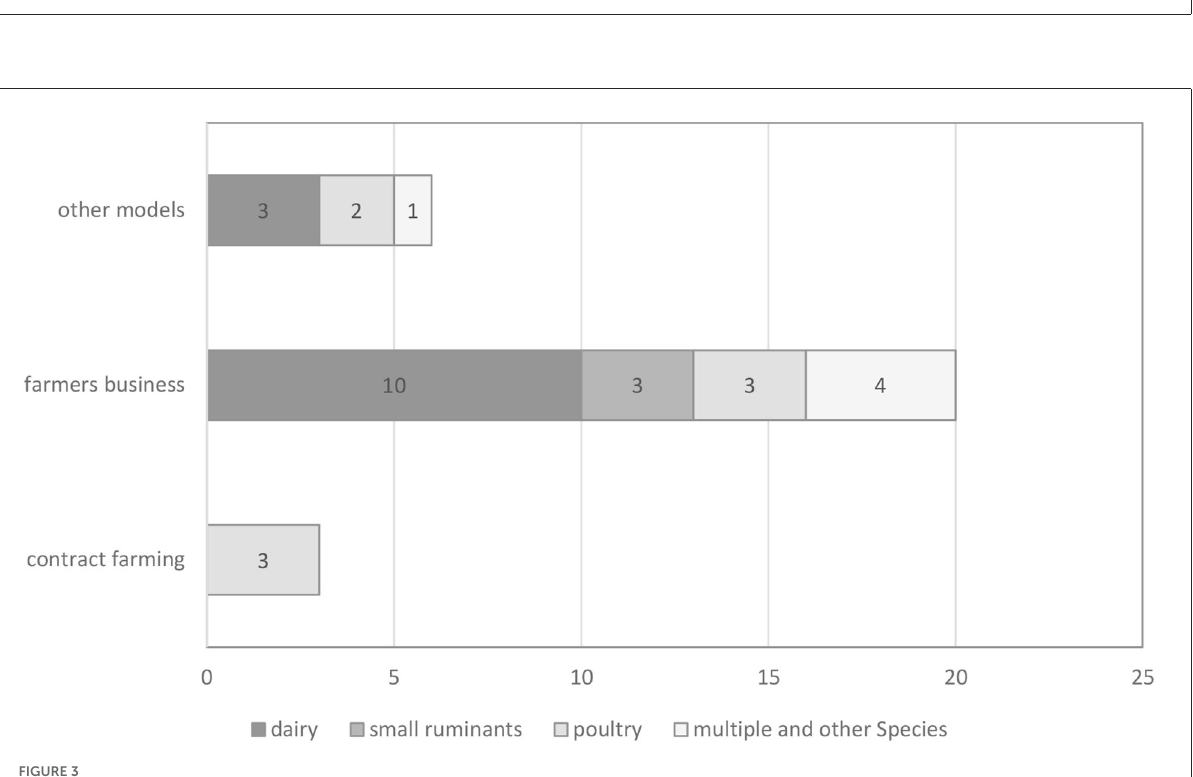
FIGURE2 Number of studies by IBM and publication type.